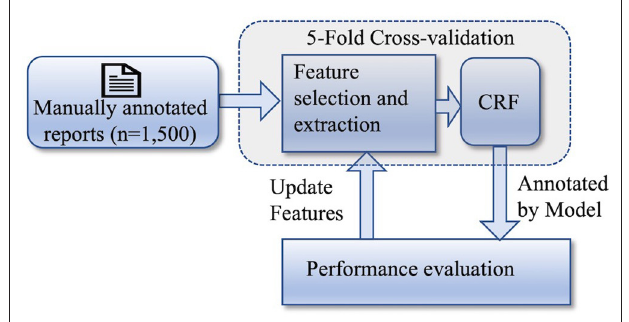
FIGURE 1 | Workflow of the 1st stage of the experiment: identifying the best feature set.